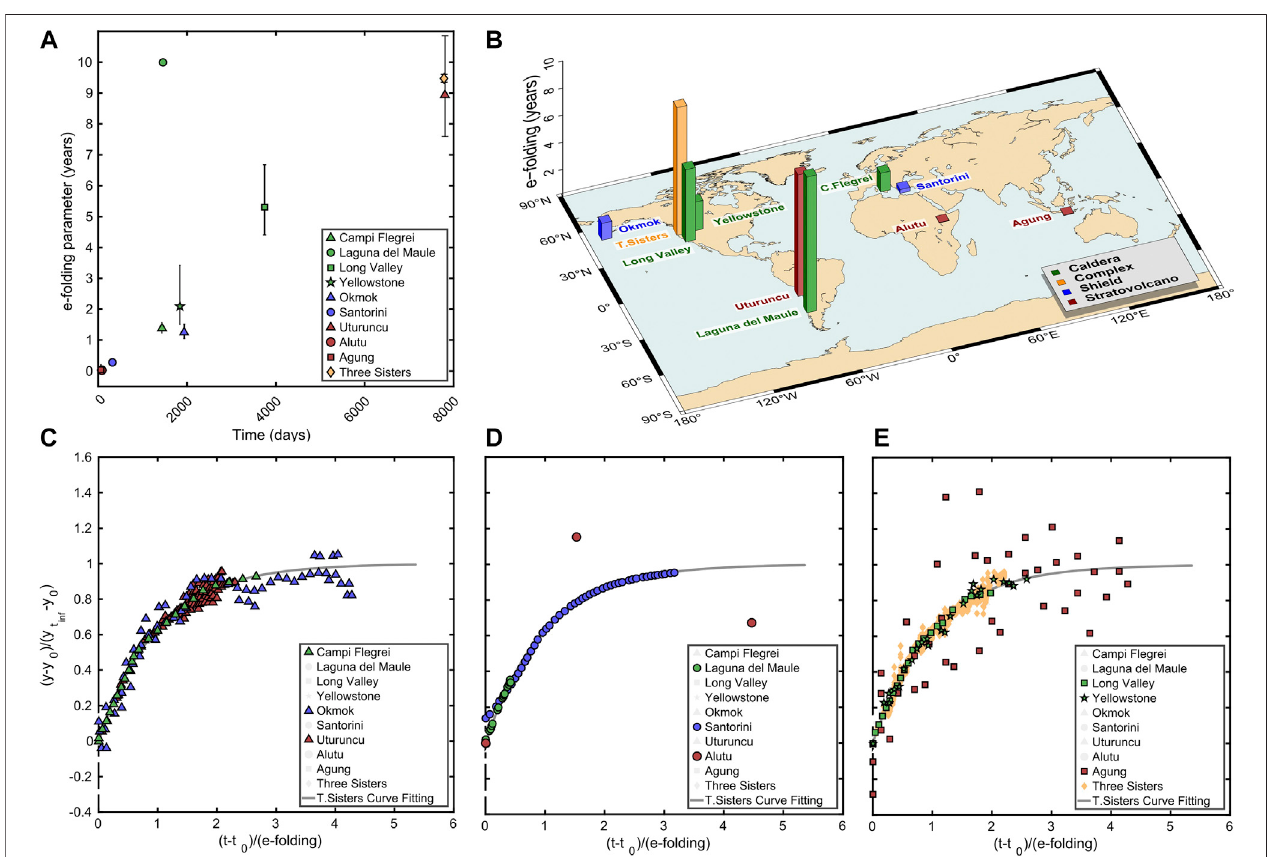
FIGURE 11 | (A) Estimated e-folding parameter of other available geodetic and volume time series from volcanoes with recent and well-studied unrest episodes: Okmok (Biggs et al., 2010), Long Valley (Hill et al., 2020), Uturuncu (Lau et al., 2018), Laguna del Maule (Le Mével et al., 2015), Yellowstone (Tizzani et al., 2015), Campi Flegrei (Troise et al., 2007), Santorini (Parks et al., 2015)), Alutu (Hutchison et al., 2016), Agung (Syahbana et al., 2019). (B) Geographic location and classi fi cation according to the type of Volcano. (C, E, F) Normalized uplift or volume change, y ′ ( Eq. 9 ) as function of normalized time, t ′ ( Eq. 10